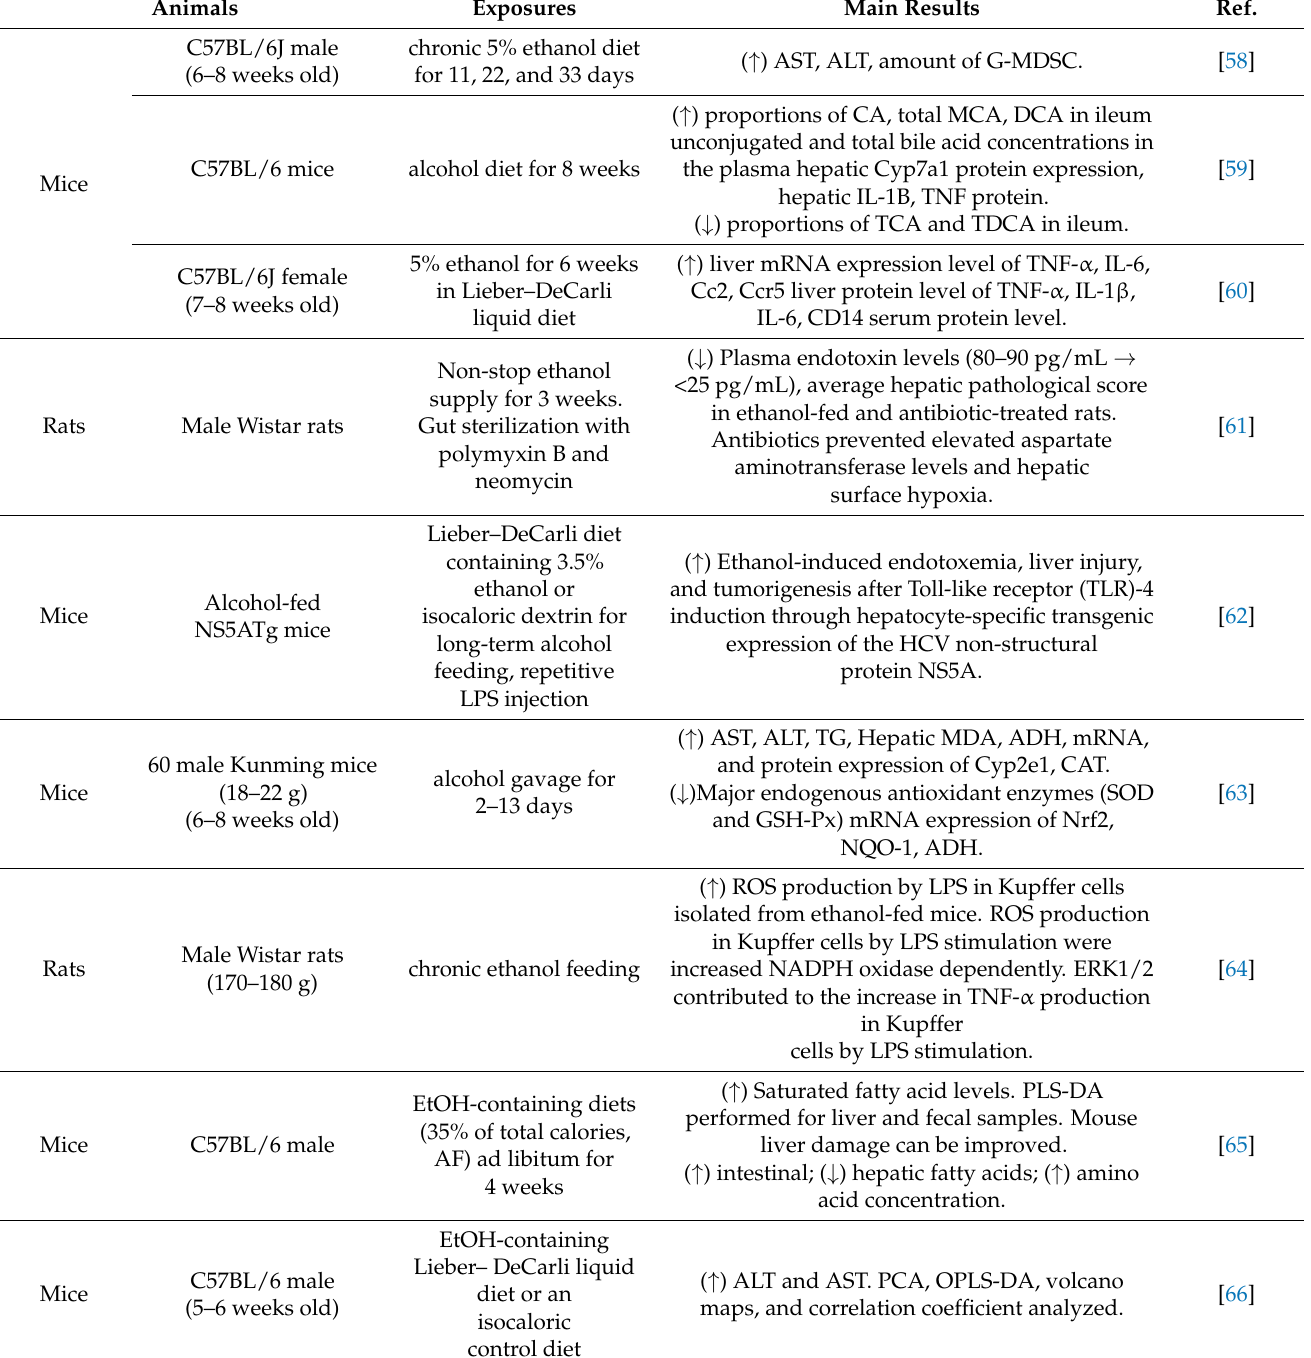
Table 1. Robust predictions of the recent genomics and metabolomics in alcoholic animal